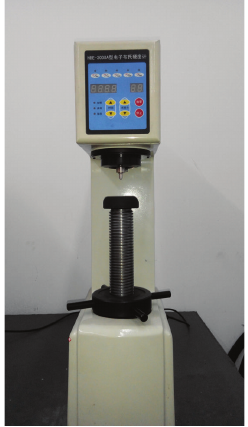
Figure 1: Hardness tester used for creating